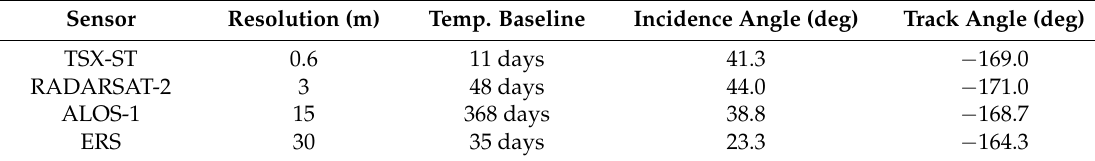
Table 6. Synthetic aperture radar (SAR) datasets used to test the warp demodulation method. Sensor Resolution (m) Temp. Baseline Incidence Angle (deg) Track Angle (deg) TSX-ST 0.6